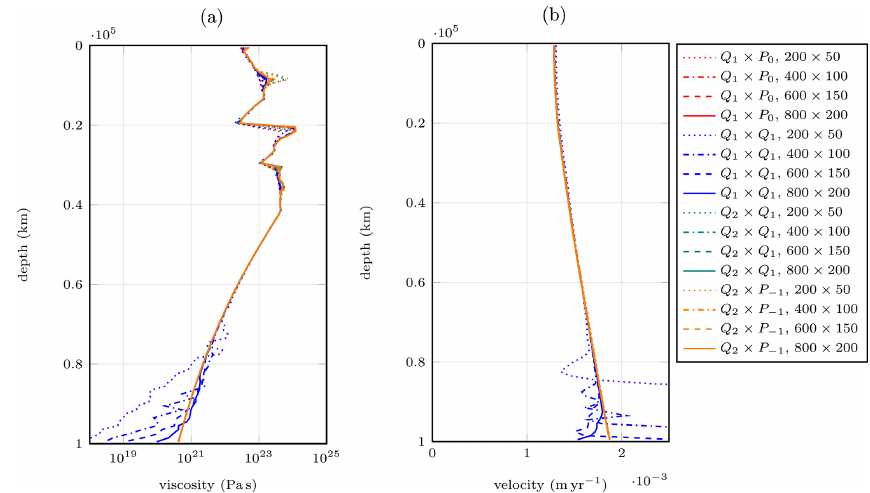
Figure 15. Application example. (a) Laterally averaged effective viscosity; (b) laterally averaged velocity magnitude. The line styles chosen become increasingly assertive (dotted to solid lines) as mesh resolution is increased.